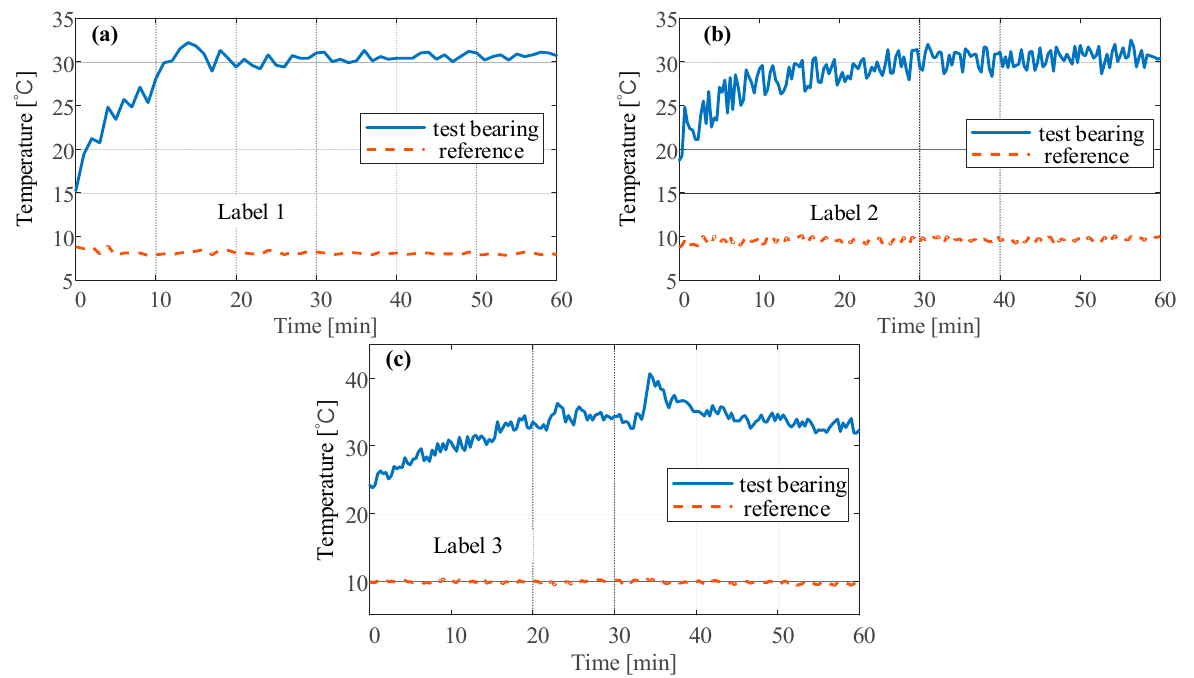
Figure 7. The temperature of the outer ring at ( a ) normal ( b ) unbalance ( c ) abrasive wear.